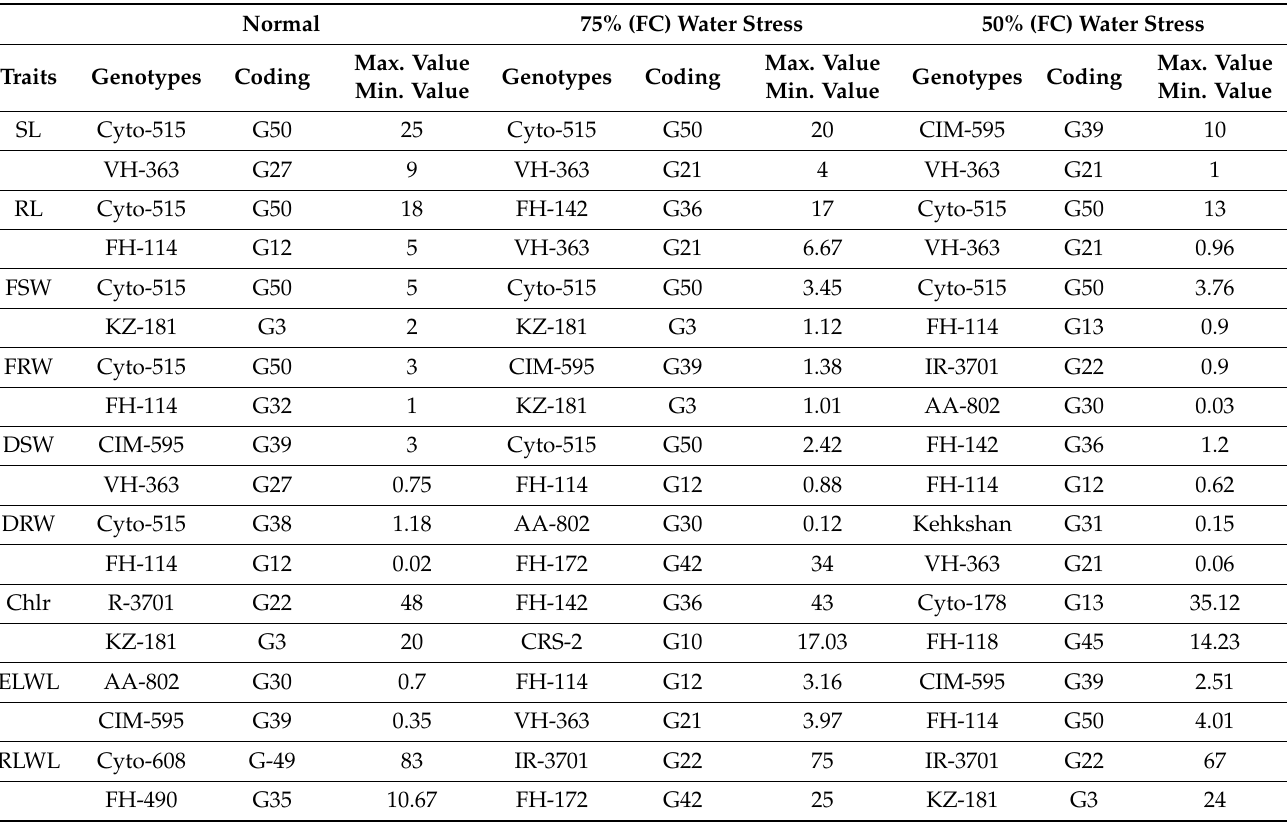
Table 2. Maximum and minimum values and representative genotypes for the parameters of cotton grown under normal and drought stress